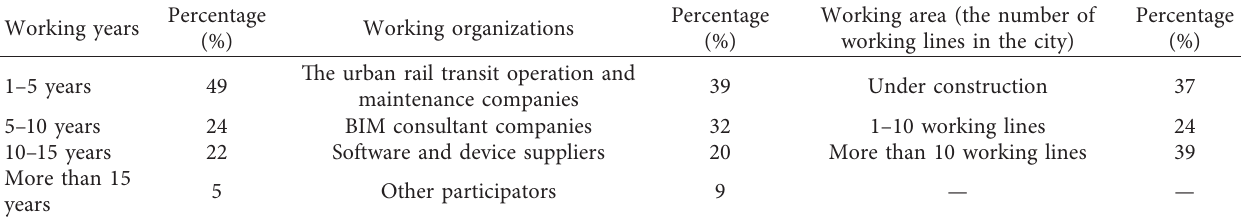
Table 3: Demographic characteristics of the respondents surveyed.